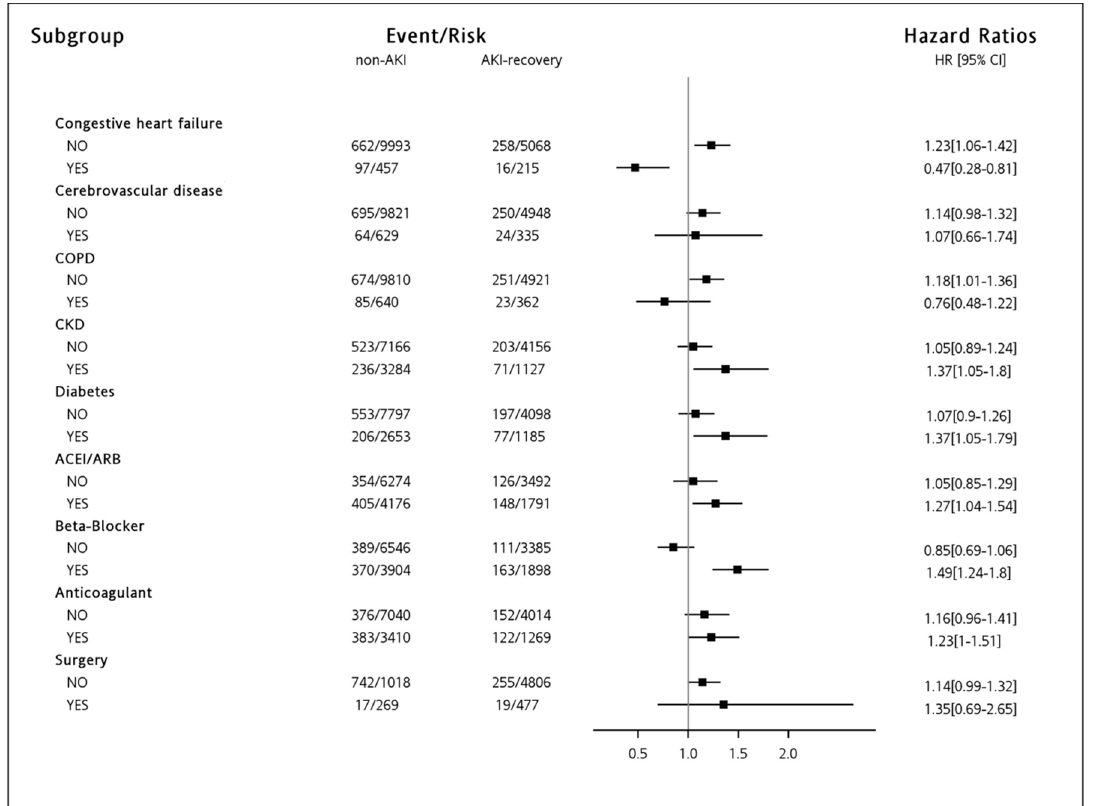
Figure 3. Subgroup comparisons for the risk of atrial fibrillation. Note: The forest plot for the comparison of AKI-recovery group versus non-AKI group was drawn using the before-matching population with adjustment to the Charlson Comorbidity Index, age, and gender. Abbreviations: ACEI, angiotensin-converting enzyme inhibitor; ARB, angiotensin receptor blocker; AF, atrial fibrillation; AKI, acute kidney injury; CKD, chronic kidney disease; COPD, chronic obstructive pulmonary disease.